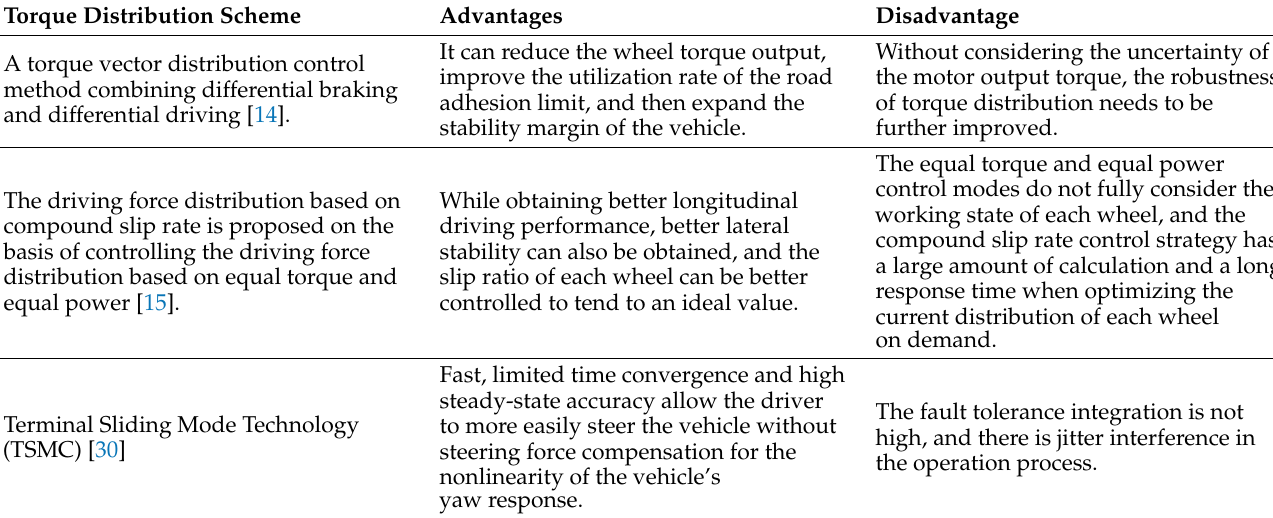
Table 1. In-wheel motor torque distribution scheme and its advantages and disadvantages. Torque Distribution